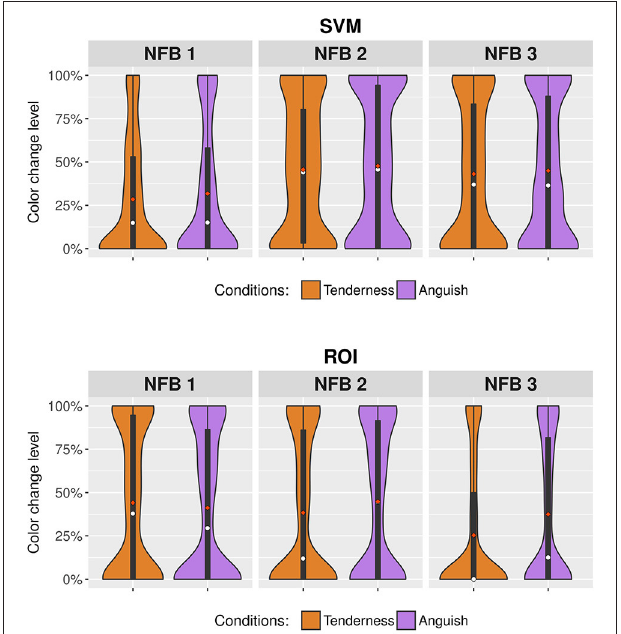
FIGURE 6 | Differential rtfMRI-NFB-related brain responses for tenderness and anguish conditions. Tenderness vs. anguish rtfMRI-NFB recruited the septo-hypothalamic area, the frontal pole and the precuneus. Anguish vs. tenderness rtfMRI-NFB recruited a more widespread network including the superior/middle frontal cortex, frontal pole, parietal cortical regions, temporal regions (middle and inferior) and other regions (lateral occipital, central operculum, cerebellum). Results were estimated across all participants ( N = 16, two scans per subject) via fixed-effect analysis and whole-brain FWE correction with p < 0.05, T >